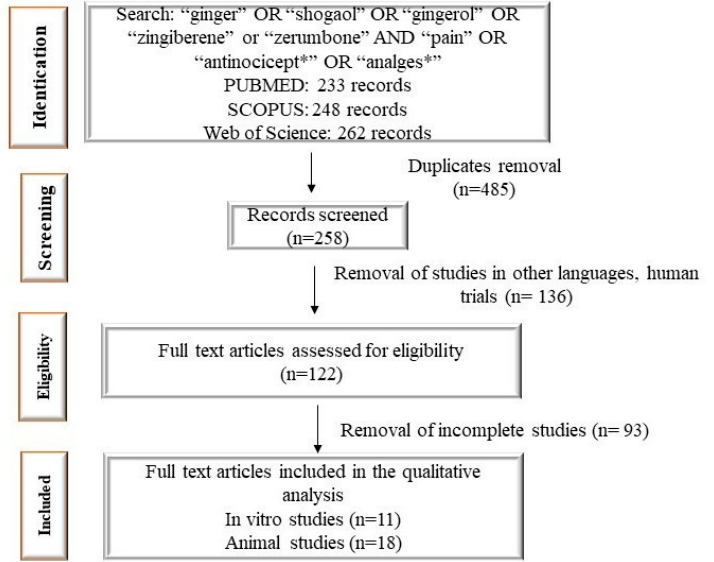
Figure 2. Studies included in the narrative review.